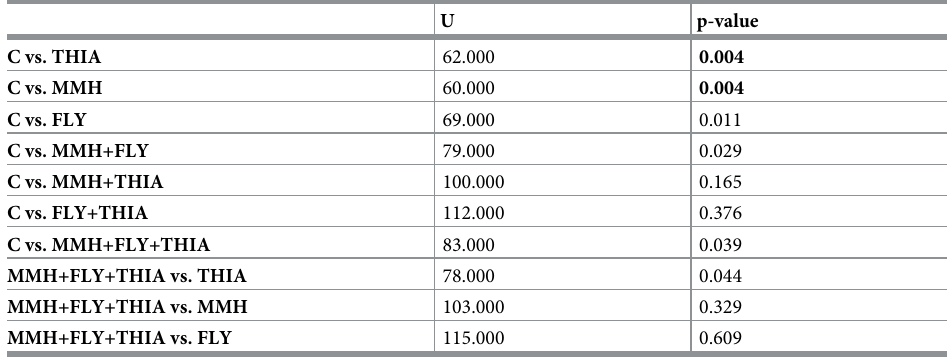
Table 3. Pairwise differences in lytic like activity of honeybee workers after feeding on different stressors.